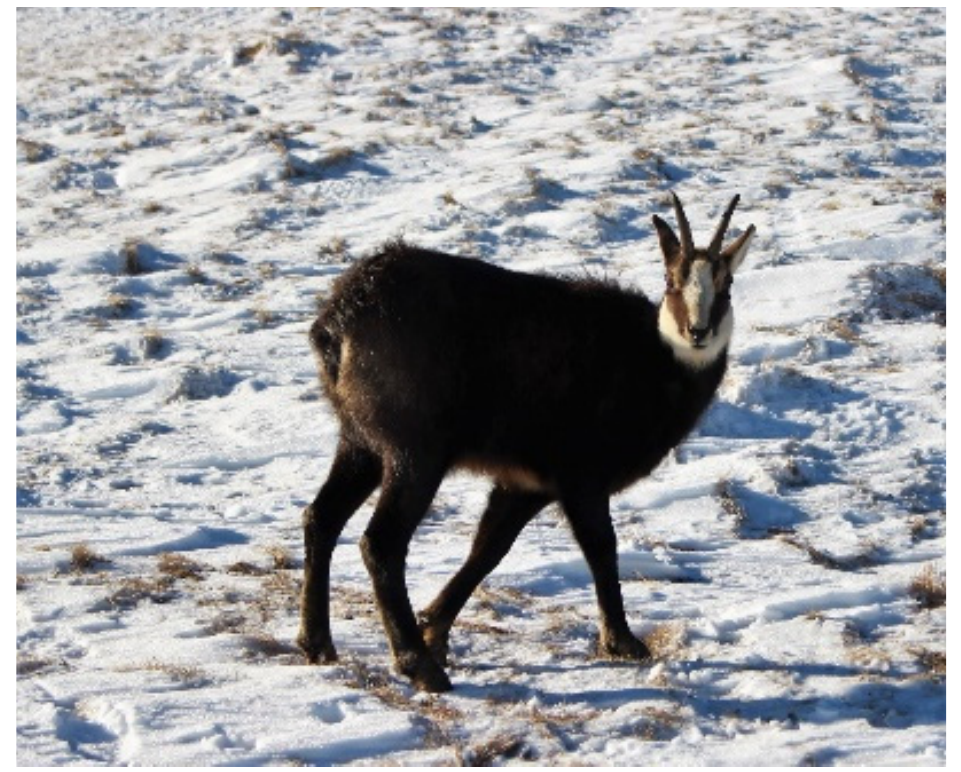
Figure 14. Alpine chamois in its natural environment in the Ď umbier Tatras (photo P. Urban).